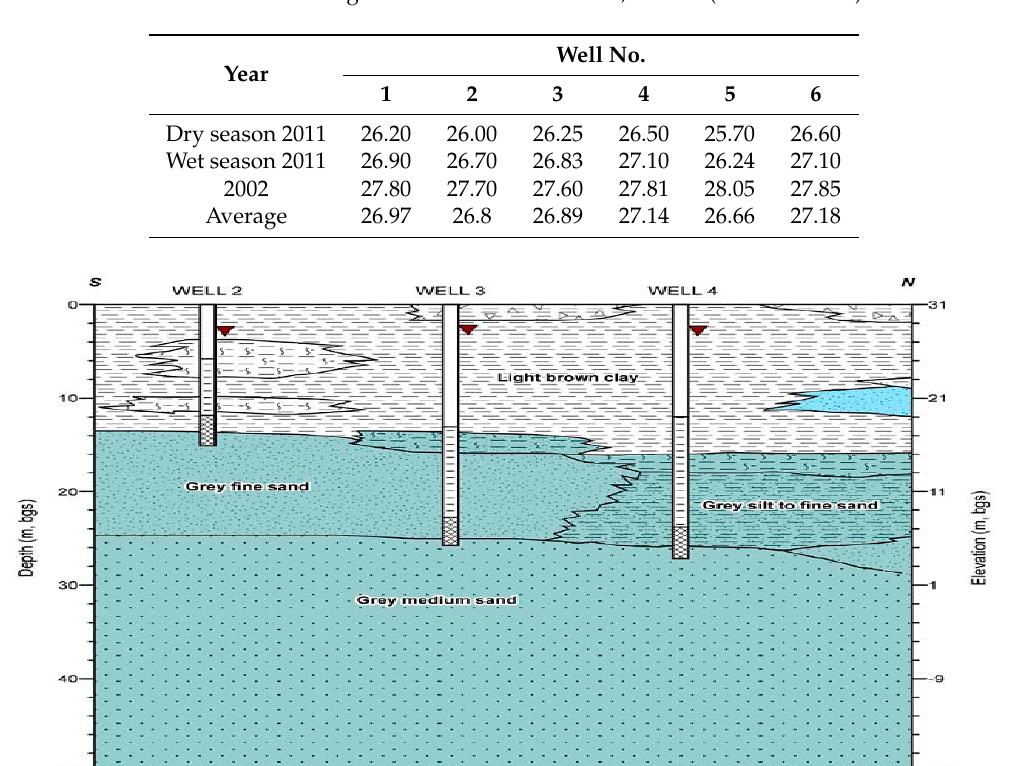
Figure 2. Hydrogeological cross-section of the study area.